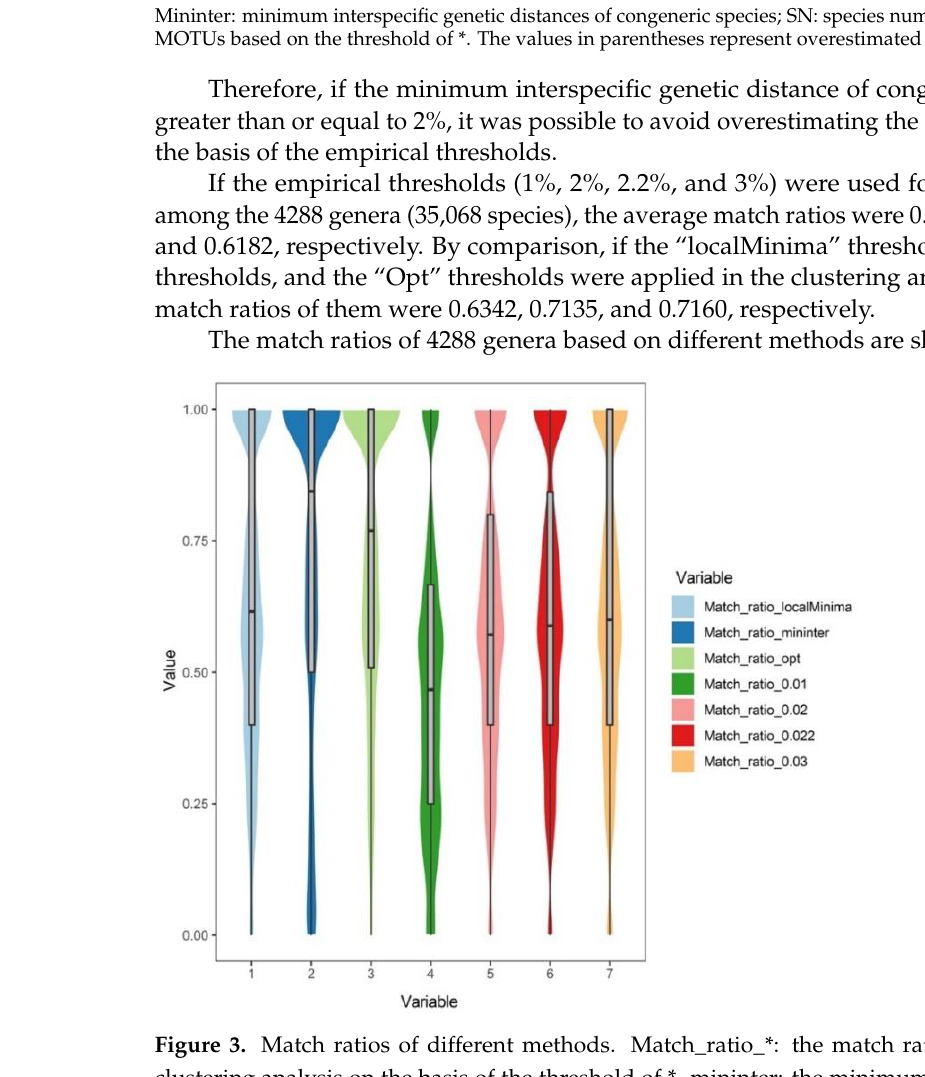
Mininter: minimum interspecific genetic distances of congeneric species; SN: species number; M_*: the number of MOTUs based on the threshold of *. The values in parentheses represent overestimated ratios. Therefore, if the minimum interspecific genetic distance of congeneric species was